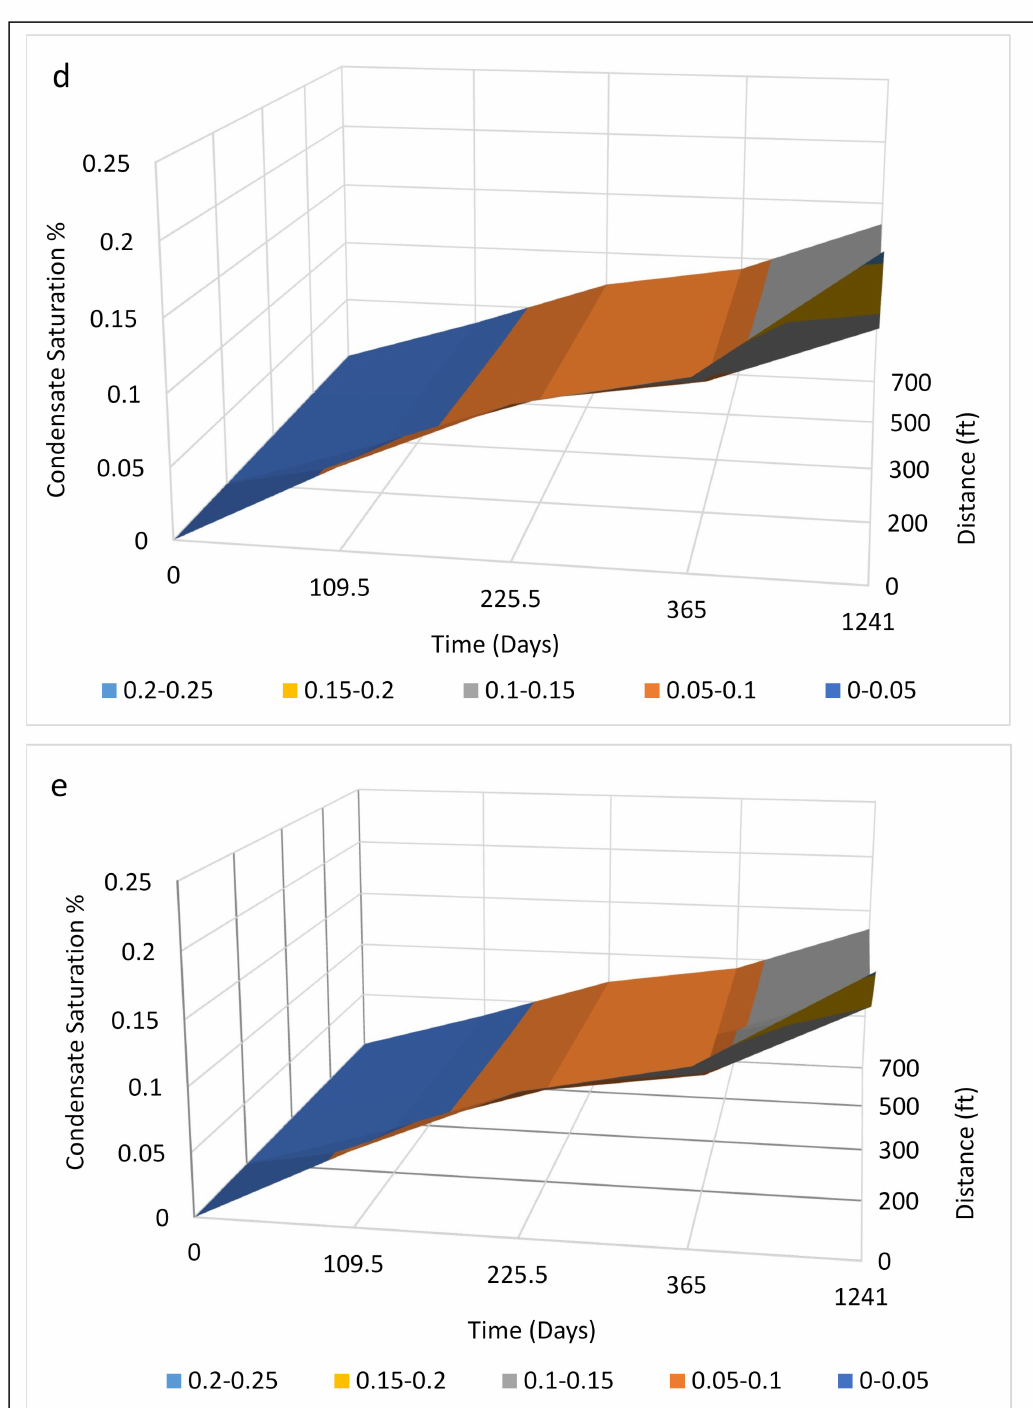
Figure 16. 3D plots for reservoirs in local analysis with values of permeability of: ( a ) 1 mD; ( b ) 5 mD; ( c ) 10 mD; ( d ) 50 mD; and ( e ) 100